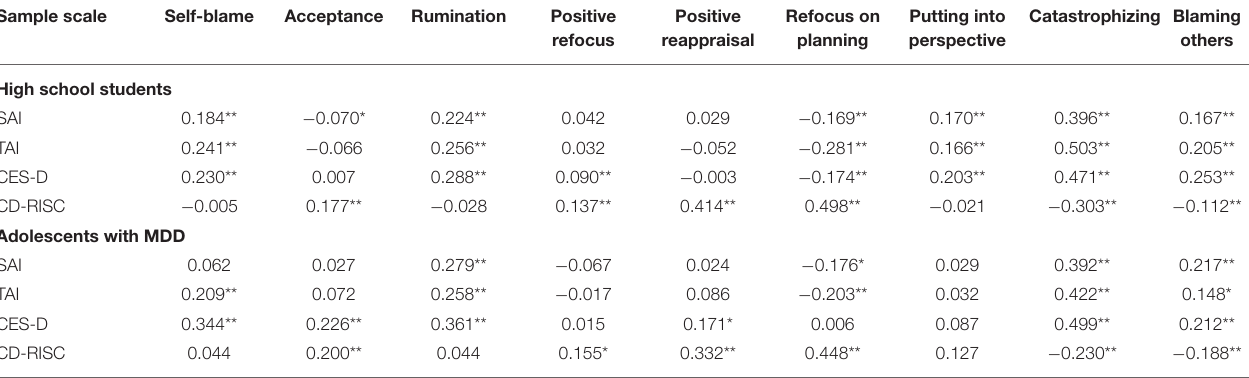
TABLE 3 | CERQ-C subscale score correlations with the depression, anxiety, and resilience. Sample